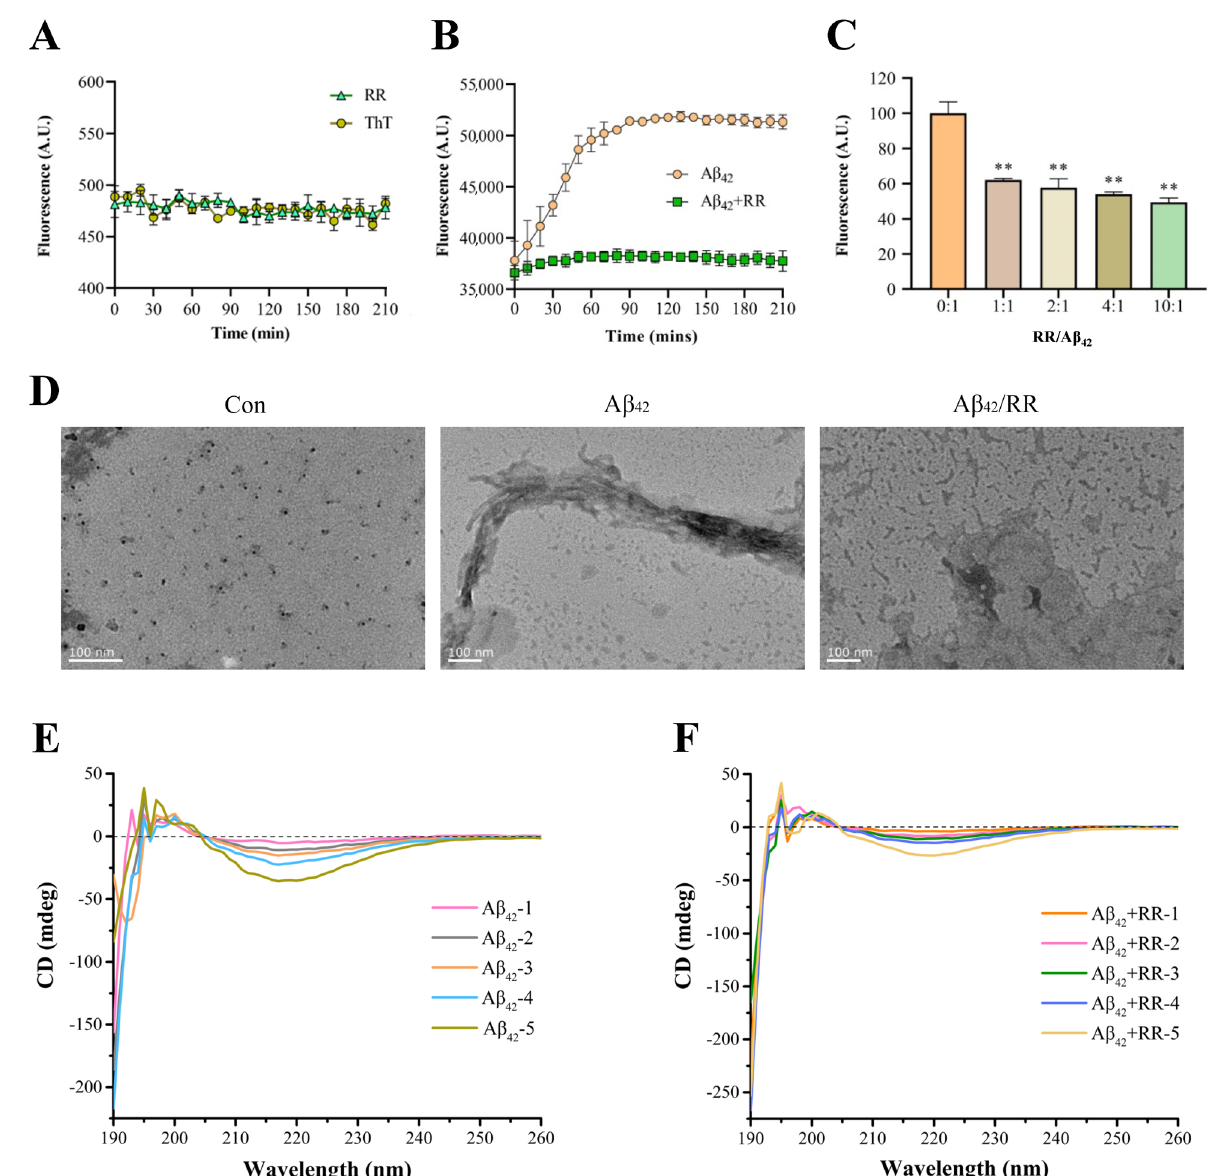
Figure 8. Effects of arginine dipeptide on aggregation of Aβ 42 . ( A ) Control experiment of the effects of arginine dipeptide on Thioflavin T (ThT) fluorescence intensity. At each data point, the sample size, n, is equal to 4. ( B ) Time-dependent effects of RR on A β 42 aggregation detected by ThT fluorometry. Fluorescence intensity was measured at the wave length of 485 nm. p < 0.01, analyzed by one-way ANOVA, n = 4. ( C ) Dose-dependent effects of RR on A β 42 aggregation detected by ThT fluorometry. Data are expressed as mean ± SE. ** p < 0.01 versus RR non-treated group, analyzed by one-way ANOVA followed by the Tukey’s post-hoc test for multiple comparison, n = 4. ( D ) Effects of arginine dipeptide (RR) on formation of A β 42 fibrils detected by transmission electron microscopy. ( E ) Far-UV circular di chroism (CD) spectrometry of Aβ 42 in absence of RR. Aβ 42 -1 to Aβ 42 - 5 represents different concentration of Aβ 42 , which correspond to 12.5, 25, 50, 100, and 200 µM. ( F ) Far- UV circular dichroism (CD) spectrometry of Aβ 42 in presence of RR. RR-1 to RR-5 represents different concentration of RR, which correspond to 31.25, 62.5, 125, 250, and 500 µM, respectively. A transmission electron microscope was used to investigate Aβ 42 aggregation. Fig- ure 8D displays TEM pictures of Aβ 42 with and without RR. At 0 h, Aβ 42 was mostly an